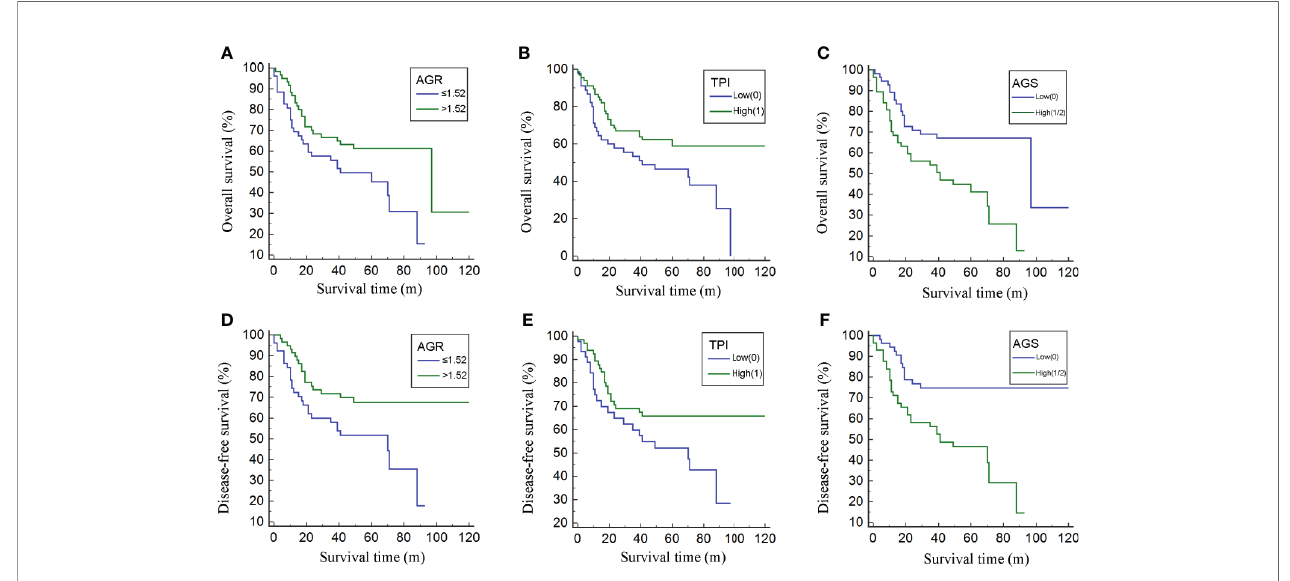
FIGURE 2 | Kaplan – Meier curves for overall survival (OS) and disease-free survival (DFS) divided by albumin to globulin ratio (AGR) (A, D) , albumin – globulin score (AGS) (B, E) , and total psoas index (TPI) (C, F)